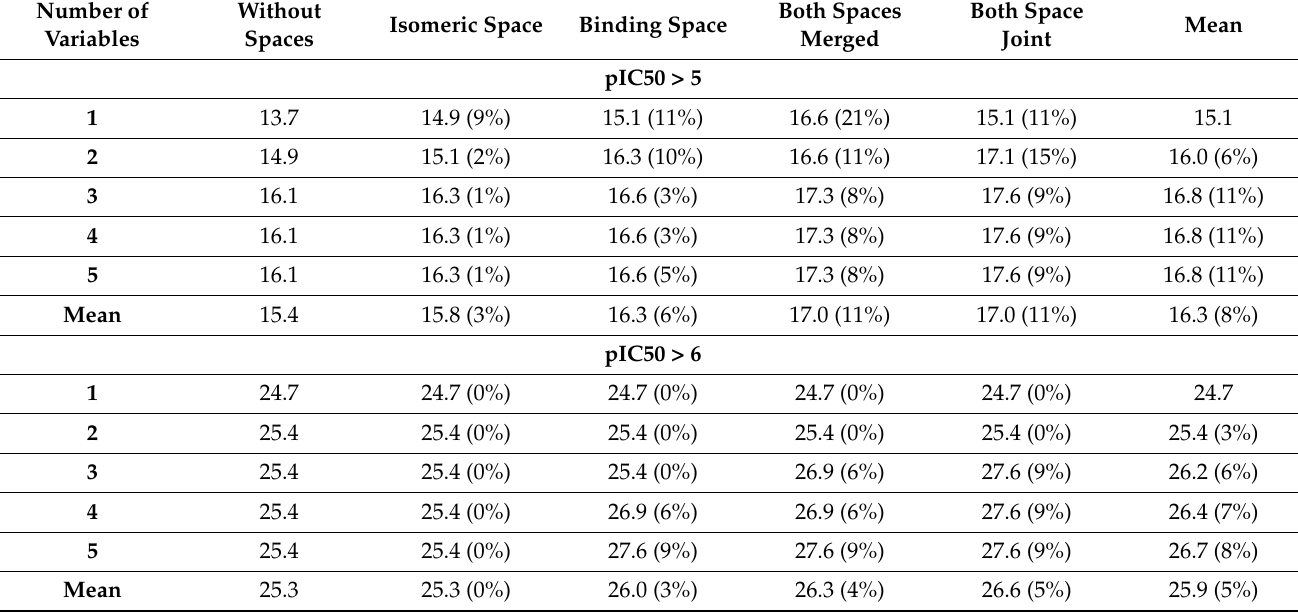
Table 4. Best EF1% values reached by the various consensus models developed using the Fred results plus the relative average values and the corresponding performance enhancements in percentage values. As described under Methods, the consensus equations were generated by linearly combining from two to five docking scores. The EF1% values referring to one variable correspond to the performances of single scoring